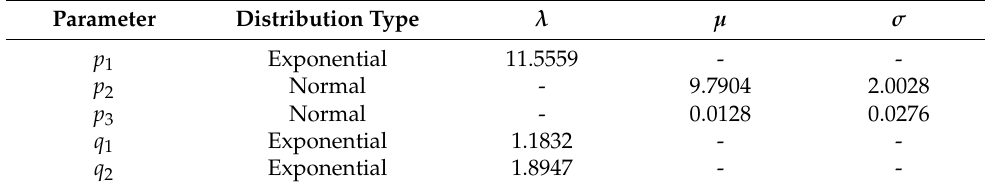
Table 1. Probability distribution of parameters in the amplitude and phase transfer functions. Parameter Distribution Type λ µ σ p 1 Exponential 11.5559 - - p 2 Normal - 9.7904 2.0028 p 3 Normal - 0.0128 0.0276 Exponential 1.1832